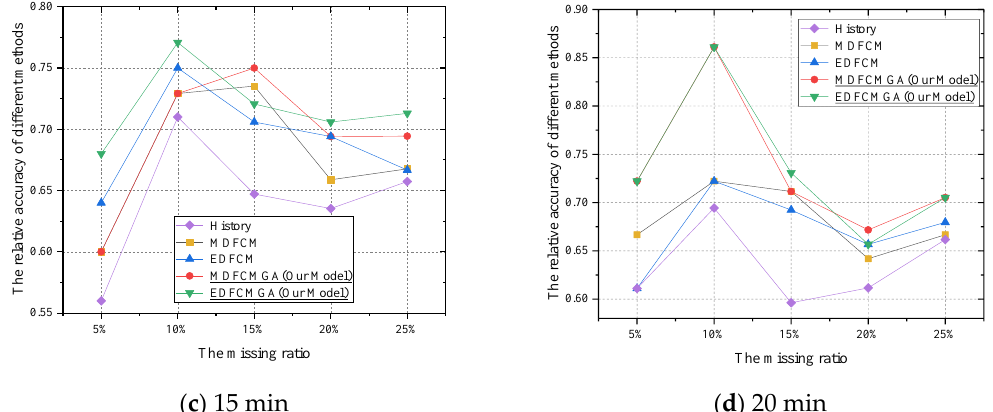
Figure 9. RA comparisons under the condition of different data aggregation intervals, different missing ratios, and the ±10% tolerance error range.